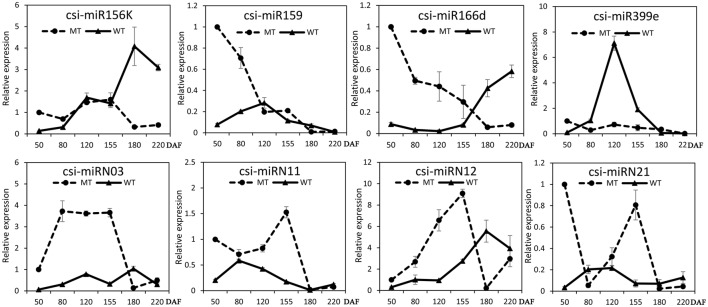
Expression patterns of several candidate miRNAs in MT and WT during fruit development and ripening. The relative expression levels were obtained from stem-loop qRT-PCR.